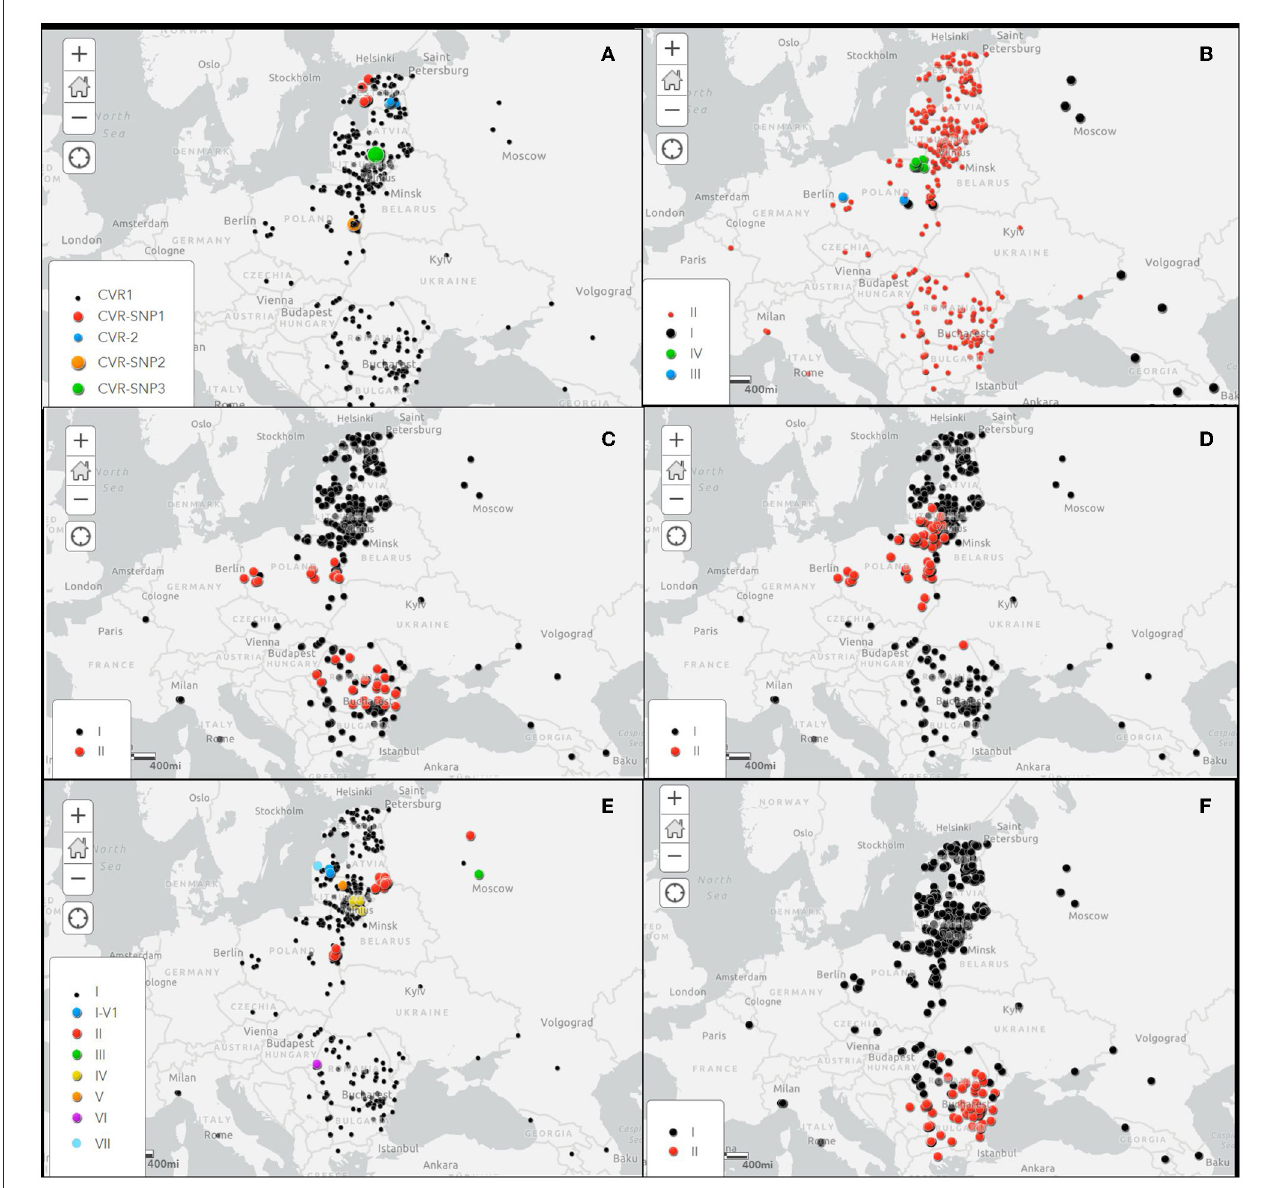
FIGURE2 Spatial distribution of investigated gene variants of ASFVs in Europe during the period 2007–2022. (A) Central variable region (CVR) within the B602L gene, (B) Intergenic region (IGR) between I73R / I329L genes, (C) O174L gene, (D) K145R gene, (E) IGR between the 9R / 10R multigene family 505 (MGF505), and (F) ECO2 variants in the IGR between the I329L / I215L and partial I215L gene. Black dots shows the variant 1 100% homologous to the Georgia2007/1 reference